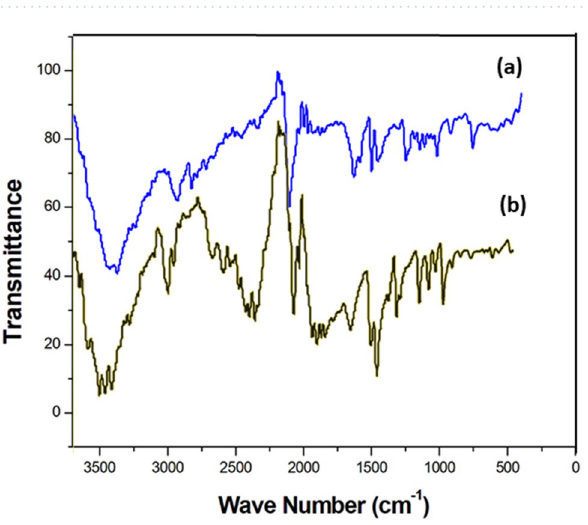
Figure 6. Final plot of the Rietveld refinement, showing the observed patterns of ( a ) {[Co(SCN) 4 ] (C